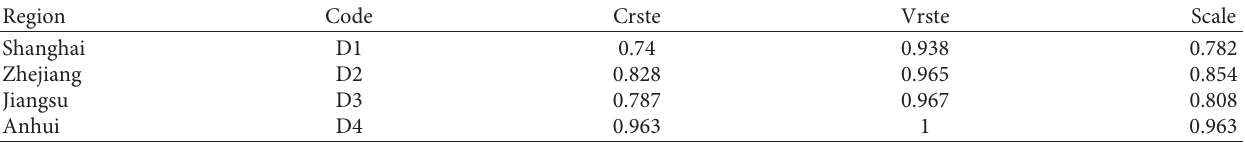
Table 10: The efficiency value of the Yangtze River Delta region.